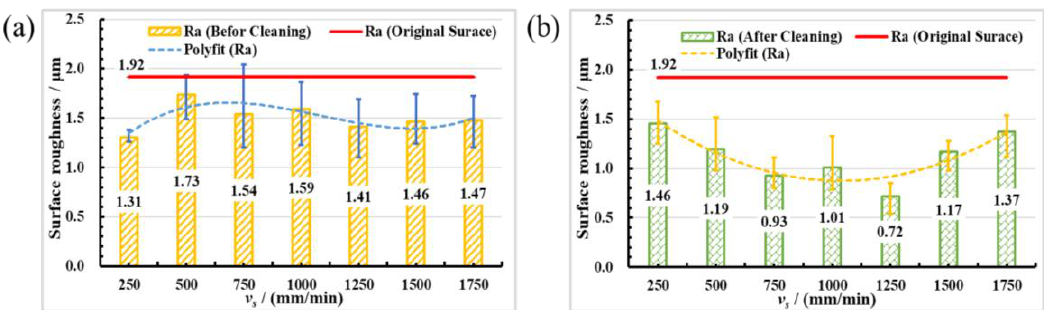
Figure 4. Variations of surface roughness of before and after cleaning with the laser scanning speed. ( a ) Before cleaning; ( b ) After cleaning (measured by LSCM at 1000× magnifications). During laser irradiation on the material surface, when the laser heat energy on the material surface reaches a certain level, the crests of material surface reach the melting point first and